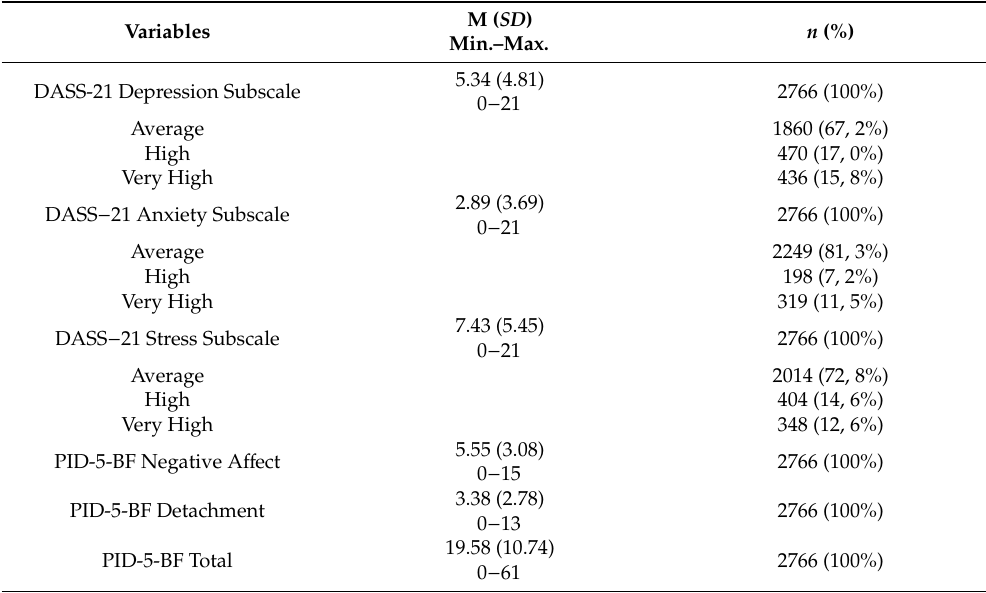
Table 2. Descriptive Statistics of Depression, Anxiety and Stress Scale–21 items (DASS-21) and Personality Inventory for DSM-5–Brief Form (PID-5-BF)